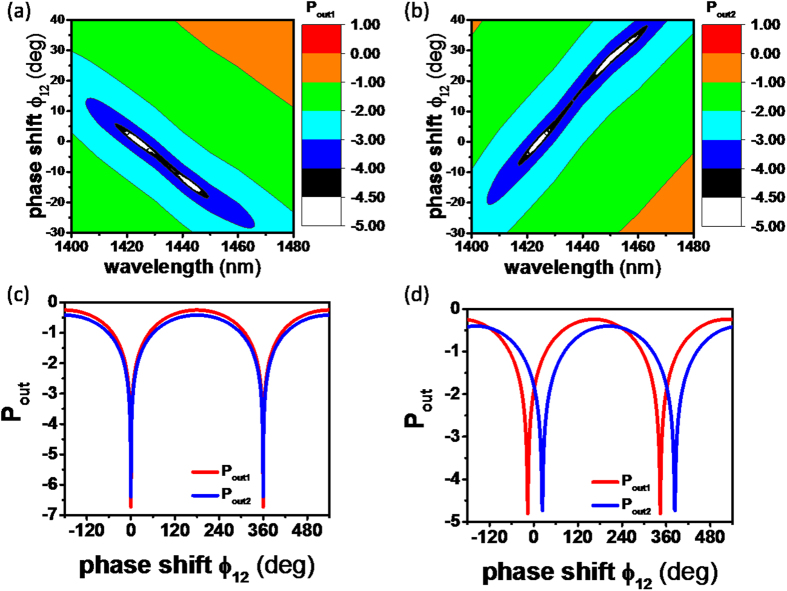
2D contour maps of (a) log(Pout1) and (b) log(Pout2) as functions of φ12 and wavelength. The color map is on the log scale. CPA occurs at 1424 nm, 0° and 1446 nm, −26° in Pout1 and 1424 nm, 0° and 1446 nm, 24° in Pout2. Calculated optical modulations of Pout1 and Pout2 on the log scale as a function of φ12 at wavelengths of (c) 1424 nm and (d) 1446 nm.